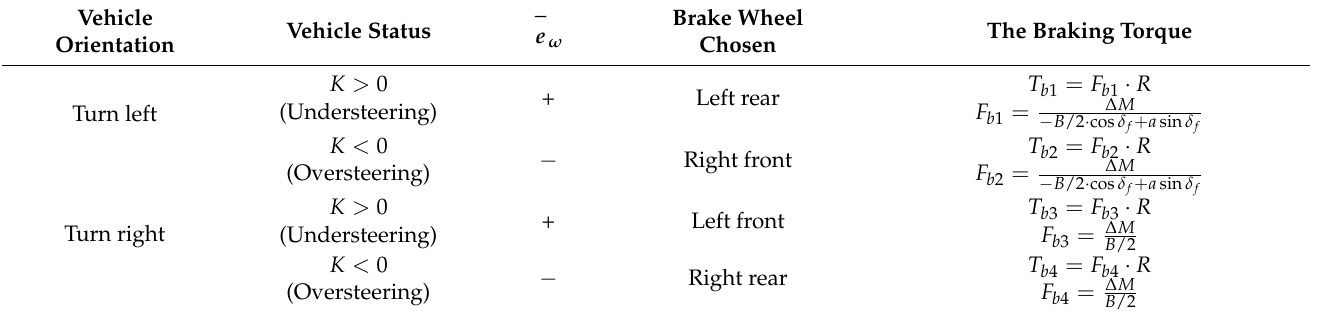
Table 1. DYC distribution strategy.